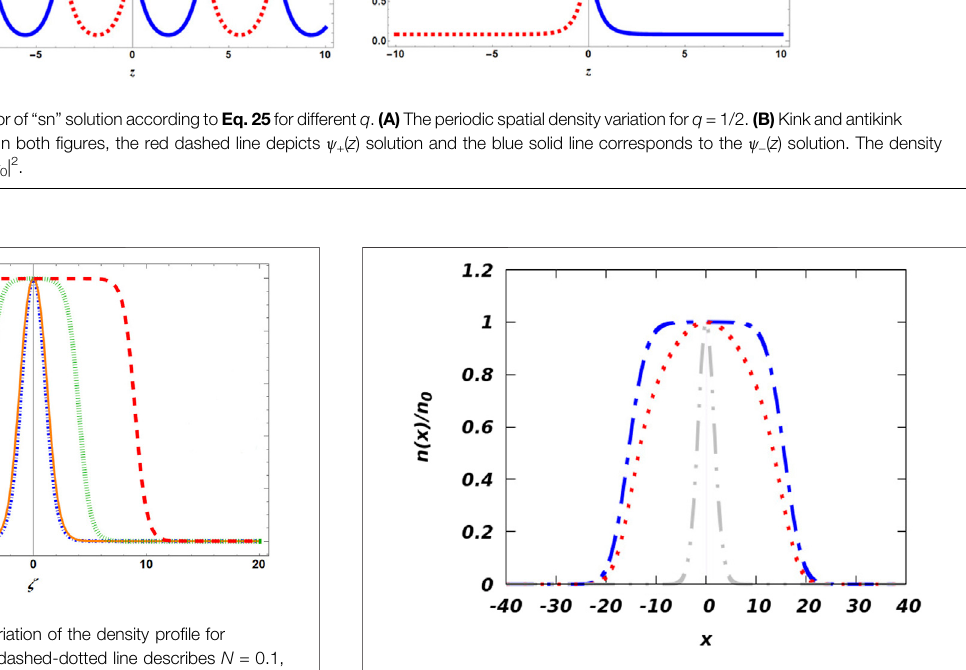
Frontiers in Physics |